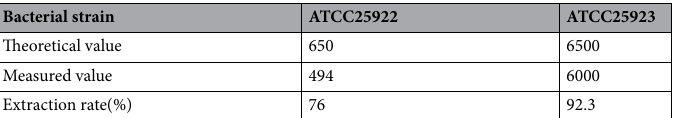
Table 4. Quantitative results of the ddPCR system simultaneously detecting two bacterial strains (bacteria counts of E. coli ∶ bacteria counts of Staphylococcus aureus = 1:10).